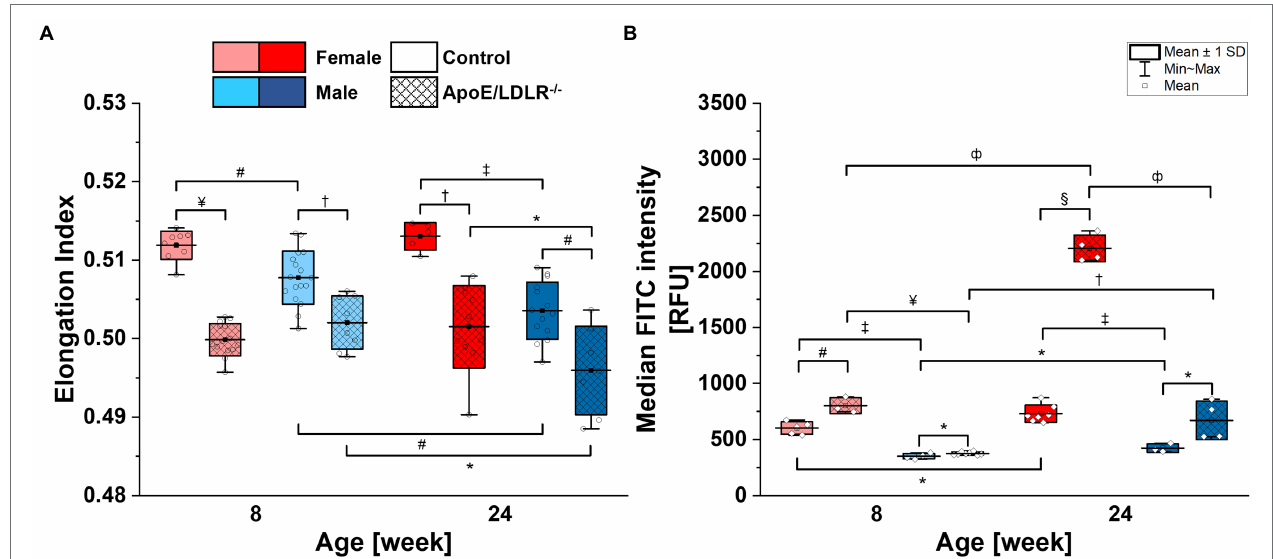
FIGURE 1 | Deformability (A) and phosphatidylserine (PS) exposure on the surface (B) of red blood cells (RBCs) isolated from 8- and 24-week-old, female and male, control and ApoE/LDLR − / − mice ( N = 3–9). Normality was assessed with Shapiro–Wilk test, statistical significance was calculated using one-way ANOVA